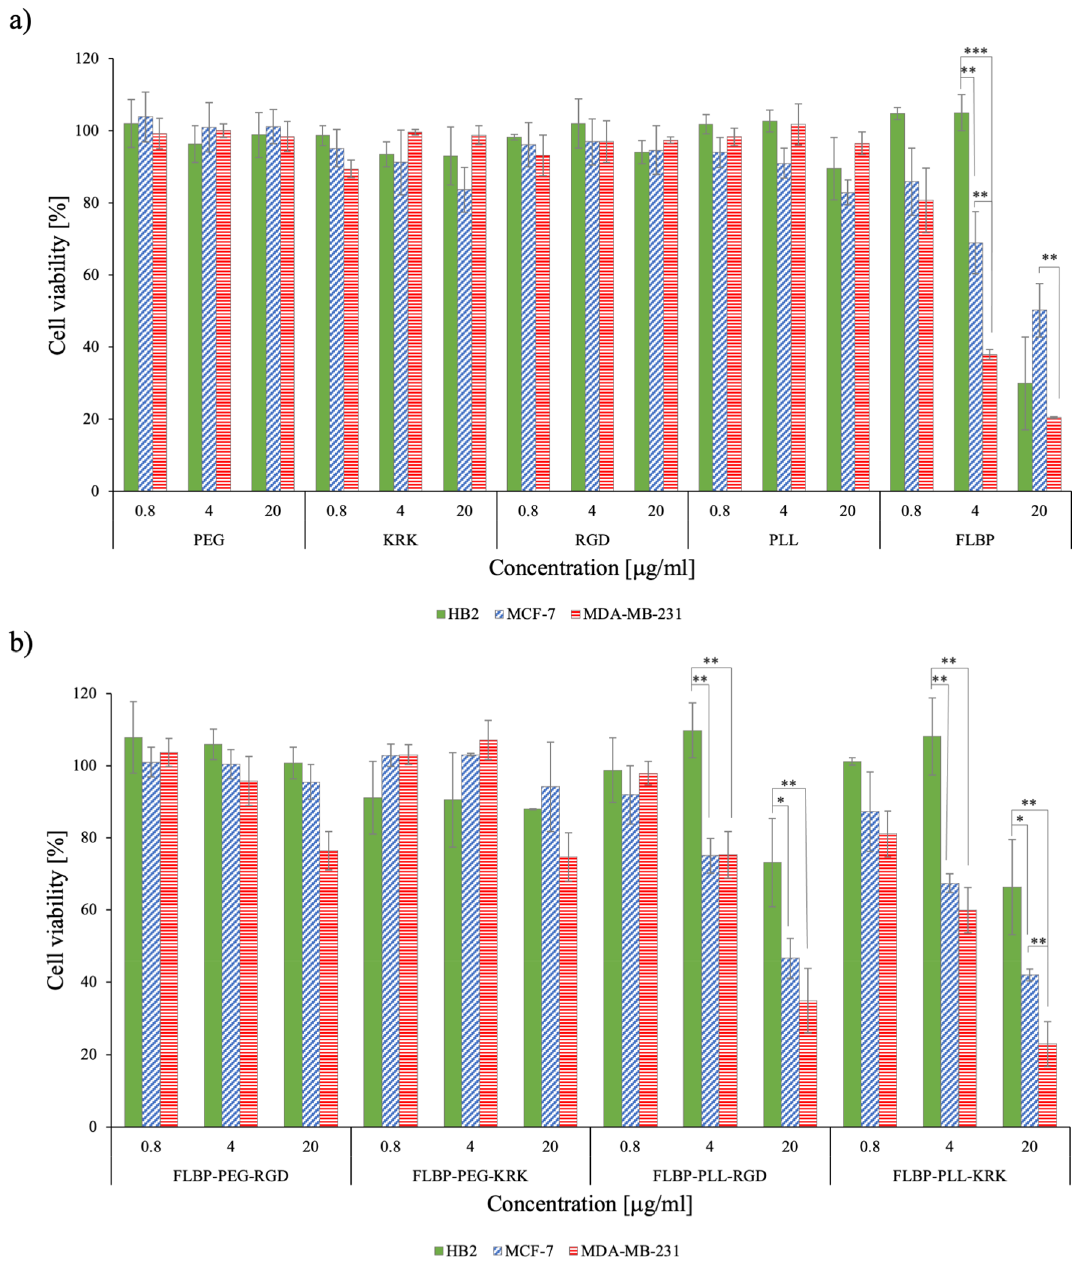
Figure 12. Cell viability [%] of three different cell lines HB2, MCF-7 and MDA-MB-231 after 72 h incubation with various concentrations (0.8, 4, 20 μg ml −1 ) of ( a ) PEG, KRK, RGD, PLL, FLBP and ( b ) FLBP-PEG-RGD, FLBP-PEG-KRK, FLBP-PLL-RGD, FLBP-PLL-KRK determined by MTT assay. Data are normalised to control (cells incubated without any additives [0 μg ml −1 ]) and presented as means ± SD (n = 3; Student’s t-test; *P < 0.05, **P < 0.01, ***P <